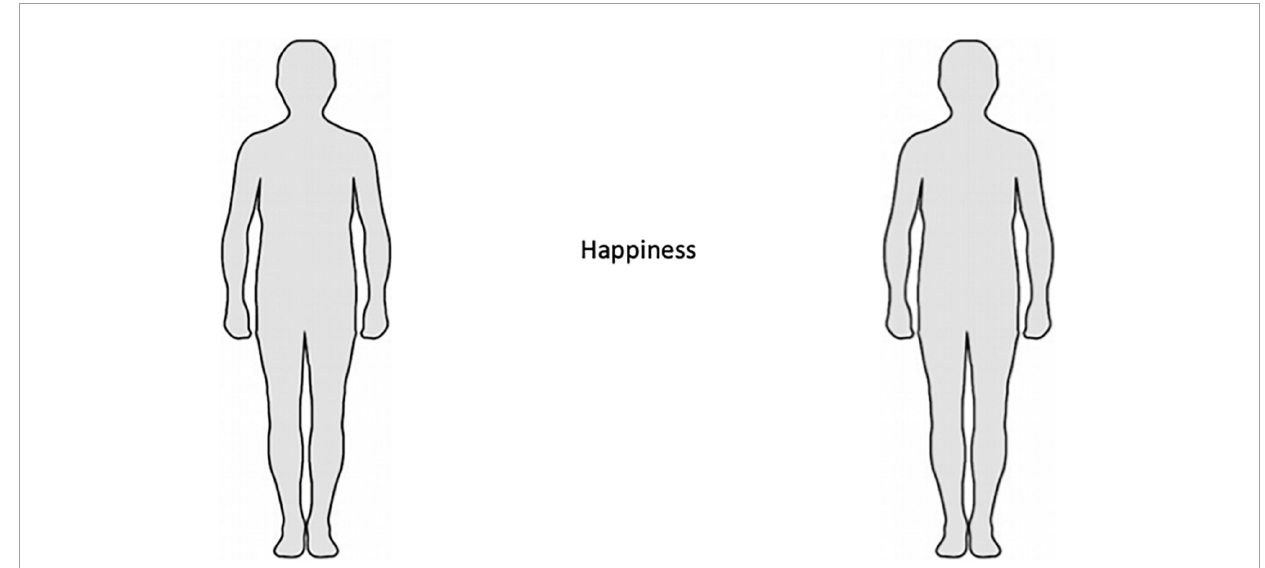
FIGURE1 EmBODY task. Participants use the computer mouse to color where on their body they feel an increase (left) or decrease (right) in activity while experiencing a given emotion (e.g., happiness).